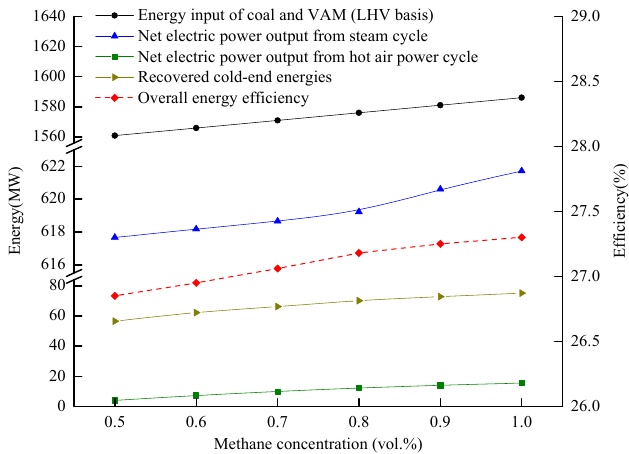
Figure 6. Influence of the methane concentration on the overall system performance.